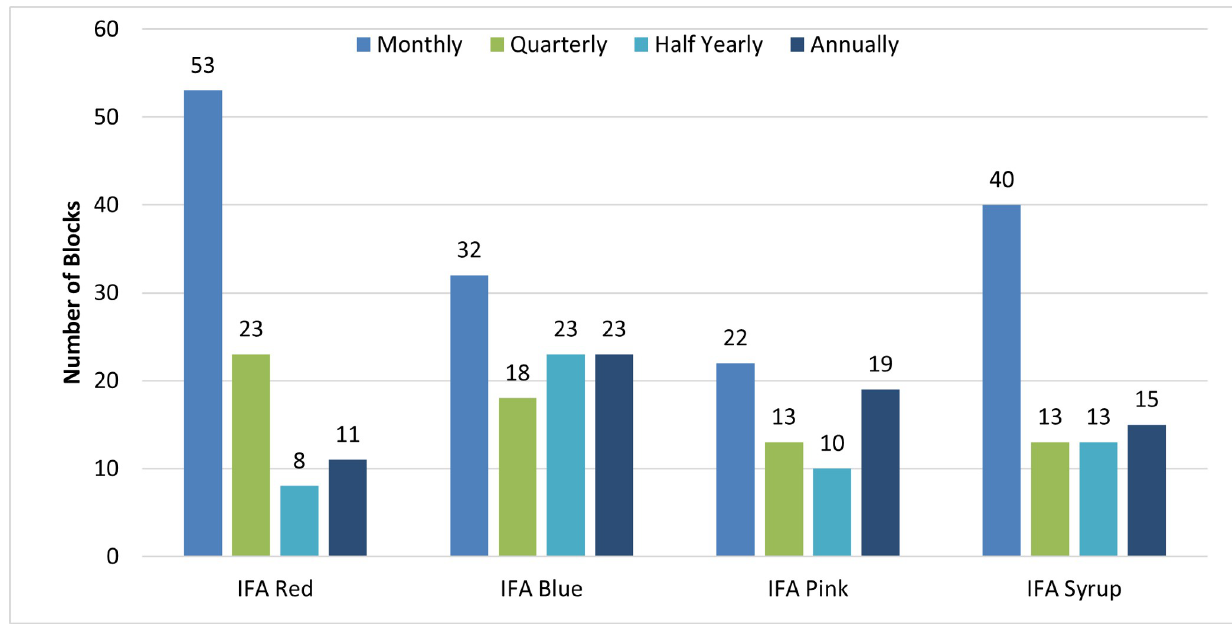
Fig 1. Frequency of IFA distribution from blocks to last-mile delivery facilities,